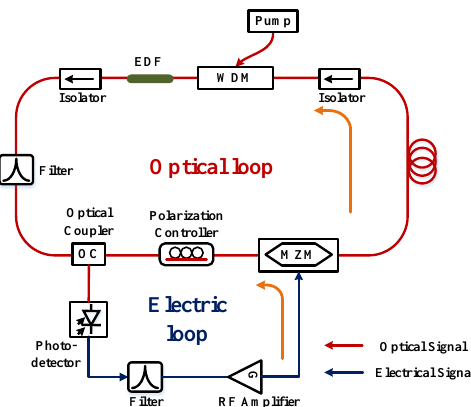
Appl. Sci. 2018 , 8 , x FOR PEER REVIEW Figure 4. The schematic diagram of coupled optoelectronic oscillator. EDF: erbium doped fiber. WDM: wavelength division multiplex.